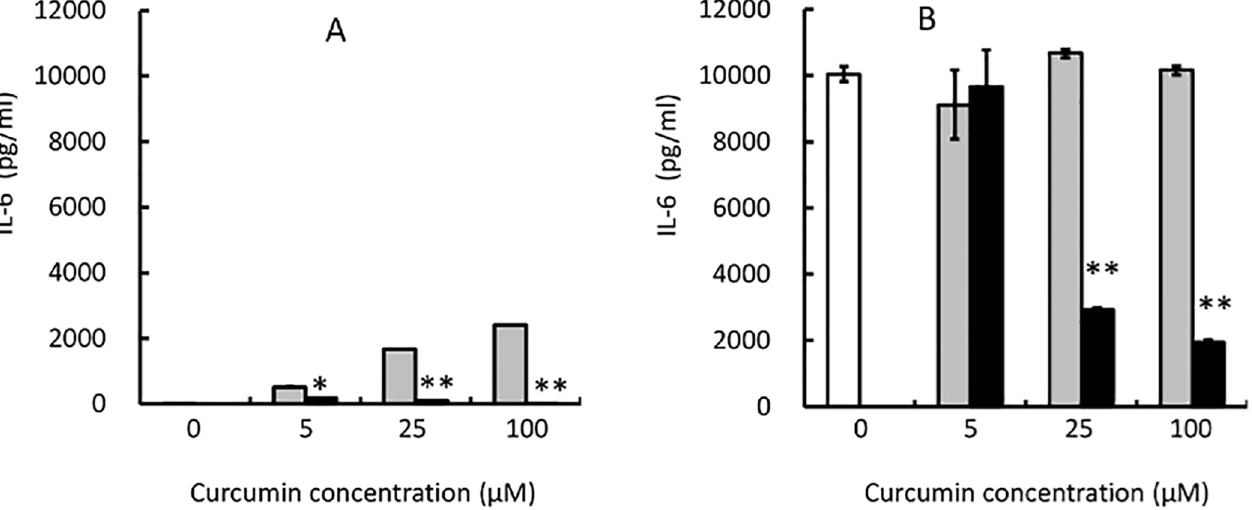
Fig 4. Effect of Curcumin/Liposome on IL-6 Production from Mouse Peritoneal Cells in In Vitro Culture. Peritoneal cells harvested from Balb/c mice injected with thioglycollate 3 days before. Peritoneal cells were cultured for 24 h in the absence (panel A) or presence (panel B) of LPS at 0.5 μ g/ml. Blank columns represent cultures absent of both curcumin/liposome and control liposome. Curcumin/liposome (filled bars) was added to the culture so that curcumin concentrations became as indicated in the Figures. Control liposomes (gray bars) were added to culture in the same manner as curcumin/ liposome, and its lipid concentration was consistent with that of curcumin/liposome. Data represent mean values ± standard deviation (bars) in triplicate assays. The statistical analysis was carried out by the standard Student ’ s t-test. * and ** indicate that P < 0.05 and P < 0.01 compared to control liposomes,